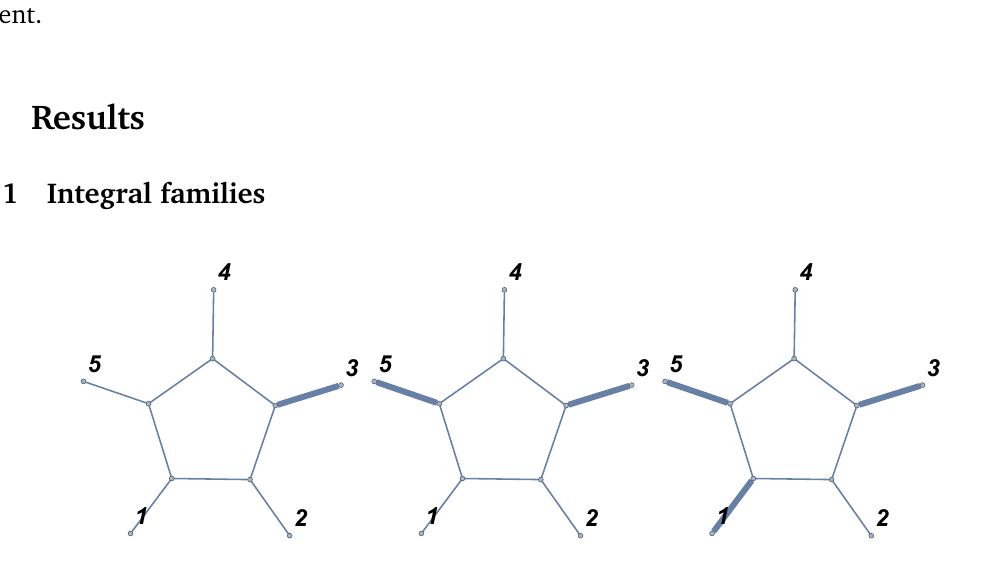
Figure 1: Top-sector MI for the pentagon families considered in this